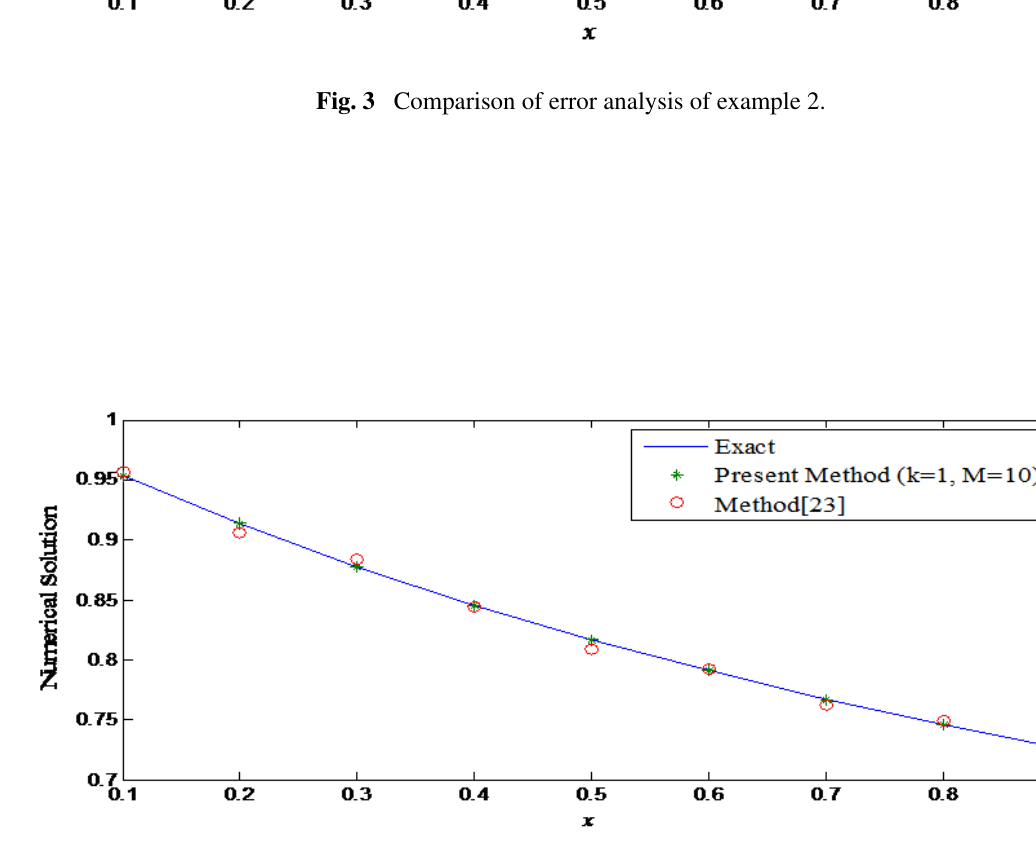
Fig. 4 Comparison of Numerical solutions of example